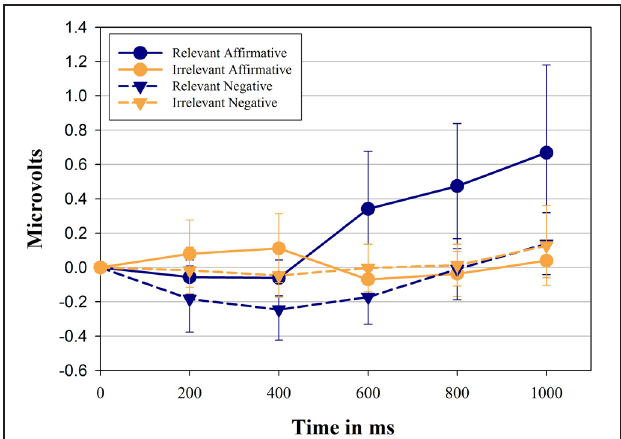
FIGURE 1 | Mean facial electromyographic (EMG) response and Confidence Intervals (CI 95%, as suggested by Cousineau, 2005) for the zygomaticus muscle. Data represent the first 1000ms of exposure to stimulus sentences and are plotted in intervals of 200ms. Results are shown separately for each category of sentences and predicates used in the study. Positive values indicate the activation of the zygomaticus compared to pre-stimulus baseline, while negative values indicate inhibition compared to pre-stimulus